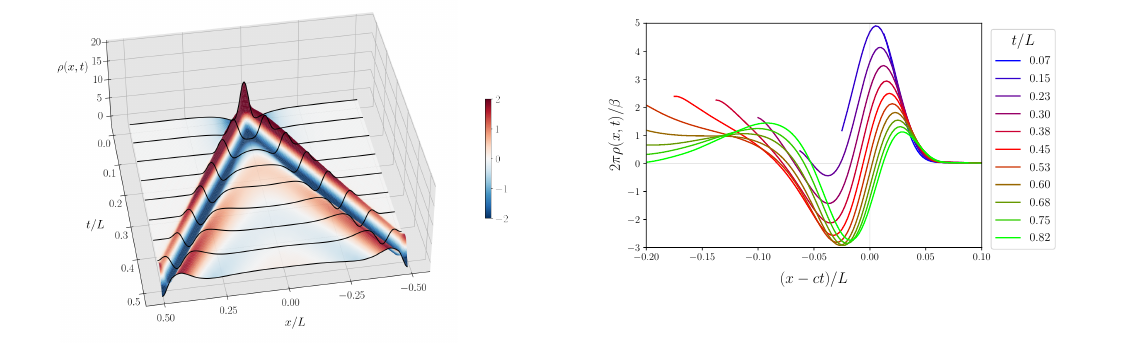
(a) 3D plot of the soliton density ρ ( x , t ) cor- responding to the case in the upper left corner of Fig. 4.6a ( β = β σ = 1 / 3). m 1